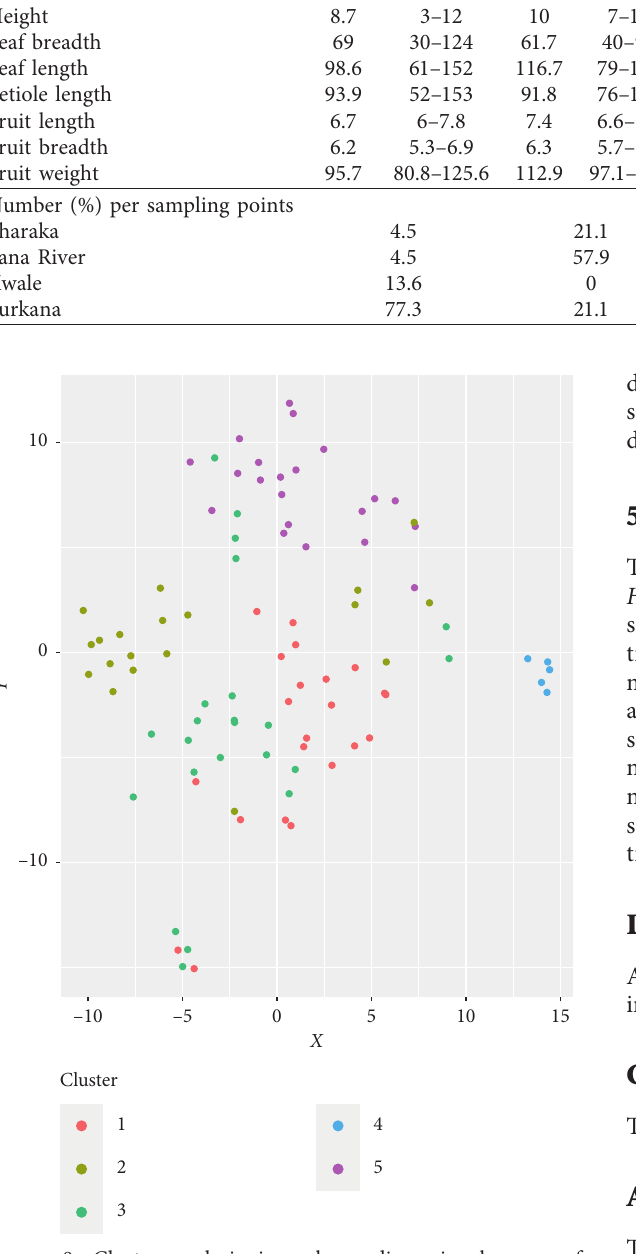
Figure 8: Cluster analysis in a lower-dimensional space of H. compressa (duom palm) accessions from Kenya based on quantitative and qualitative traits using Gower distance analysis. The morphotypes are colour